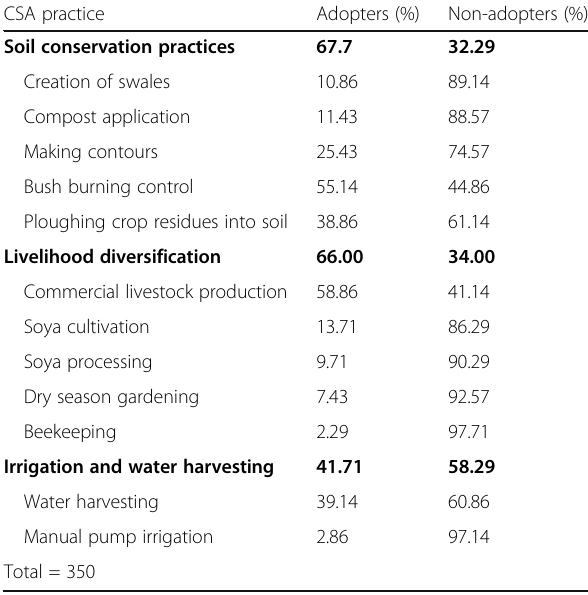
Table 3 Summary of CSA practice